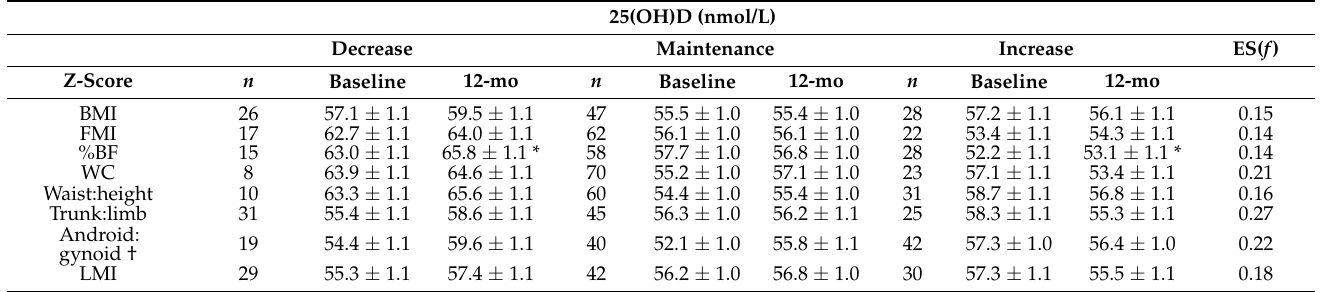
Table 2. Change in z-score between baseline and 12 mo in those who lost, maintained, and gained in each adiposity indicator.